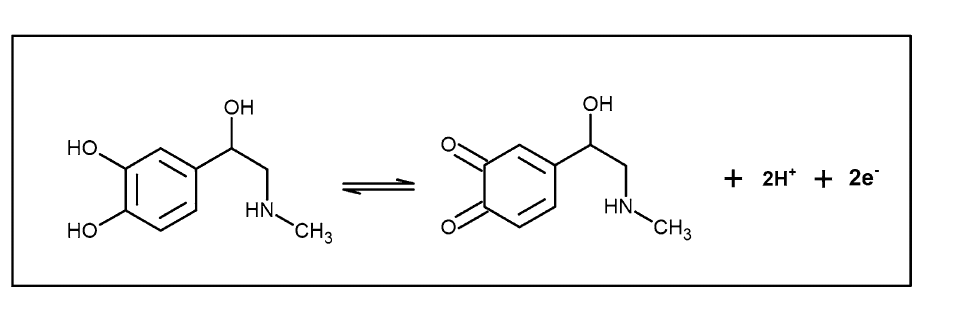
Figure 5. Oxidation of Adrenaline.